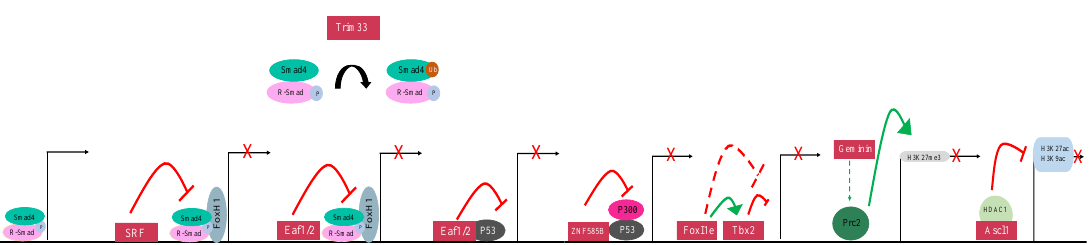
Figure 4. Nuclear regulation of mesendodermal gene silencing. Trim33 (Ectodermin) functions in the nucleus and, via ubiquitination, promotes the degradation of Smad4. At the transcriptional level, SRF prevents the association between FoxH1 and the Smad2-Smad4 complex, repressing Smad2 target genes. Eaf1 / 2 are repressors that inhibit Activin-mediated mesoderm induction via P53-dependent and P53-independent mechanisms. Eaf1 / 2 physically associates with P53, Smad2, Smad3, and FoxH1. ZNF585B (XFDL156) reduces the amount of P53 bound to P53 target sites and represses P53-induced mesodermal gene expression. FoxI1e is an activator that likely indirectly inhibits mesendodermal gene expression in the ectoderm. Tbx2, a T-box transcription factor, also represses mesendodermal gene expression. Geminin is a chromatin modifier that represses gene expression by recruiting the PRC2 complex. The PRC2 complex then trimethylates H3K27 to silence gene expression. Ascl1, another chromatin modifier, recruits HDAC1 to deacetylate H3K27 and H3K9, a mechanism that silences gene